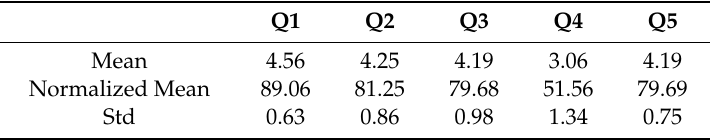
Table 1. Impact questionnaire results ( n =